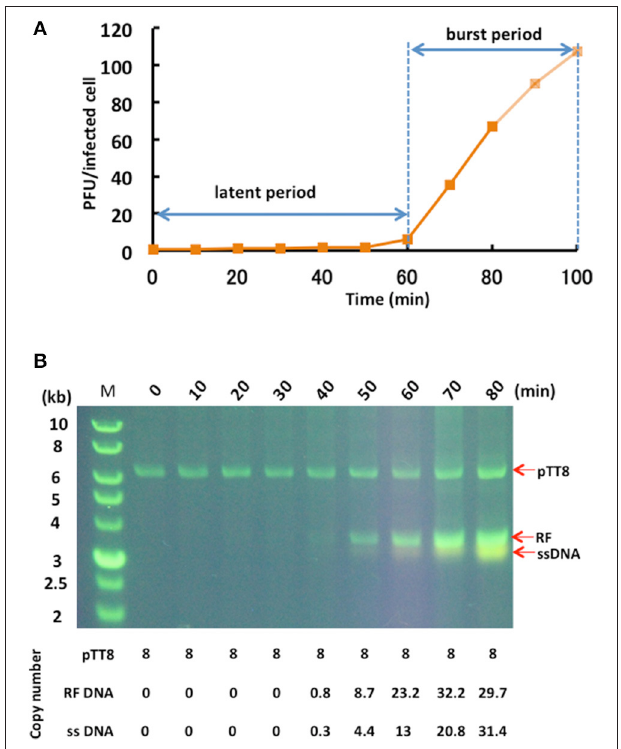
FIGURE 3 | Propagation of ϕ OH3 in T. thermophilus HB8. (A) One-step growth curve of ϕ OH3. (B) Agarose gel electrophoresis of phage ϕ OH3 genomic DNA. The ϕ OH3 genome was extracted with alkaline lysis after the indicated cultivation periods. Double stranded RF DNA and ssDNA were distinguished by acrydine orange staining. Corresponding estimated copy numbers of pTT8 (Takayama et al., 2004), RF DNA, and ssDNA of ϕ OH3 are shown under the